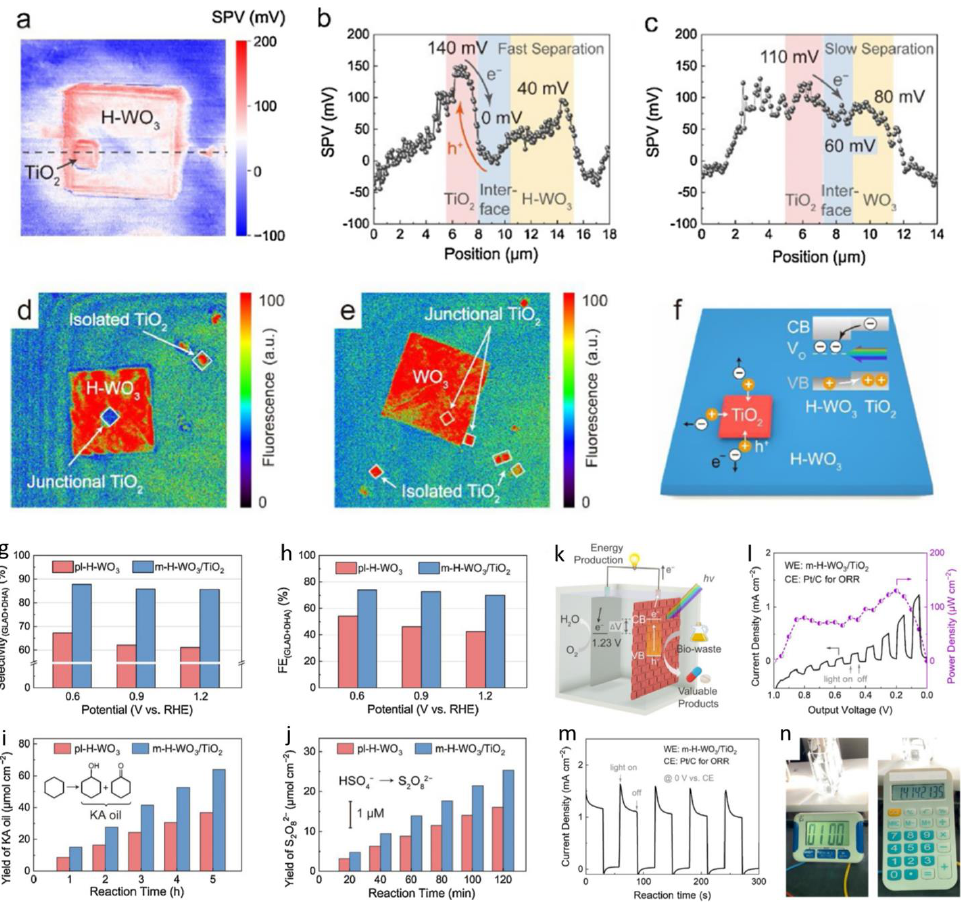
Figure 8. ( a ) Surface photovoltage (SPV) image of H−WO 3 /TiO 2 and ( b ) the representative cross−sectional SPV profiles associated with the dashed line in panel ( a ). ( c ) The representative cross−sectional SPV profiles of a defect−free WO 3 /TiO 2 heterostructure. Spatially resolved PL images of a defective ( d ) and defect-free ( e ) WO 3 /TiO 2 heterostructure. ( f ) Schematic diagram of charge separation across the defective WO 3 /TiO 2 interface. ( g ) Selectivity and ( h ) FE of pl−H−WO 3 and m−H−WO 3 /TiO 2 for the production of GLAD + DHA. ( i ) KA oil generation in the PEC oxidation of cyclohexane. ( j ) S 2 O 82− generation in the PEC oxidation of HSO 4− . ( k ) Schematic diagram of the photo−electrochemical cell with microfluidic photoanode and ORR cathode. ( l ) Chopped J–V curve of the system. The output power density is also displayed and calculated. ( m ) Chopped photocurrent−time profiles of the photo-electrochemical system at short-circuit. ( n ) Photographs displaying an electronic timer (left) and an electronic calculator (right) powered by two of the photo−electrochemical cells connected in series. Reproduced with permission [106], Copyright 2021, Elsevier Publishing Group. Cauê A. Martins and co-workers [107] developed a 3D-printed microfluidic glycerol fuel cell that generates power concomitantly to formate and glycolate. They intelligently tuned the balance between the output energy and the two carbonyl compounds generated via decorating the Pt/C/carbon paper anode in situ and before feeding reactants, or